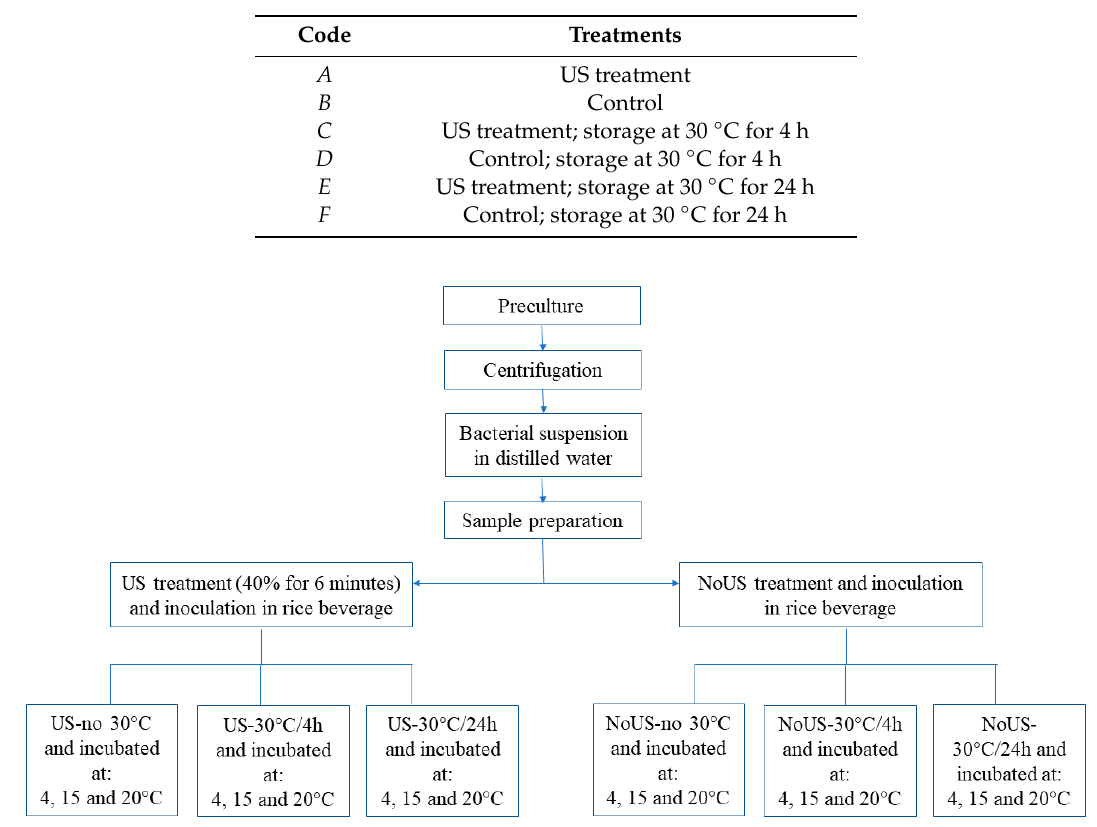
Figure 1. Flow chart for sample preparation under thermal abuse.